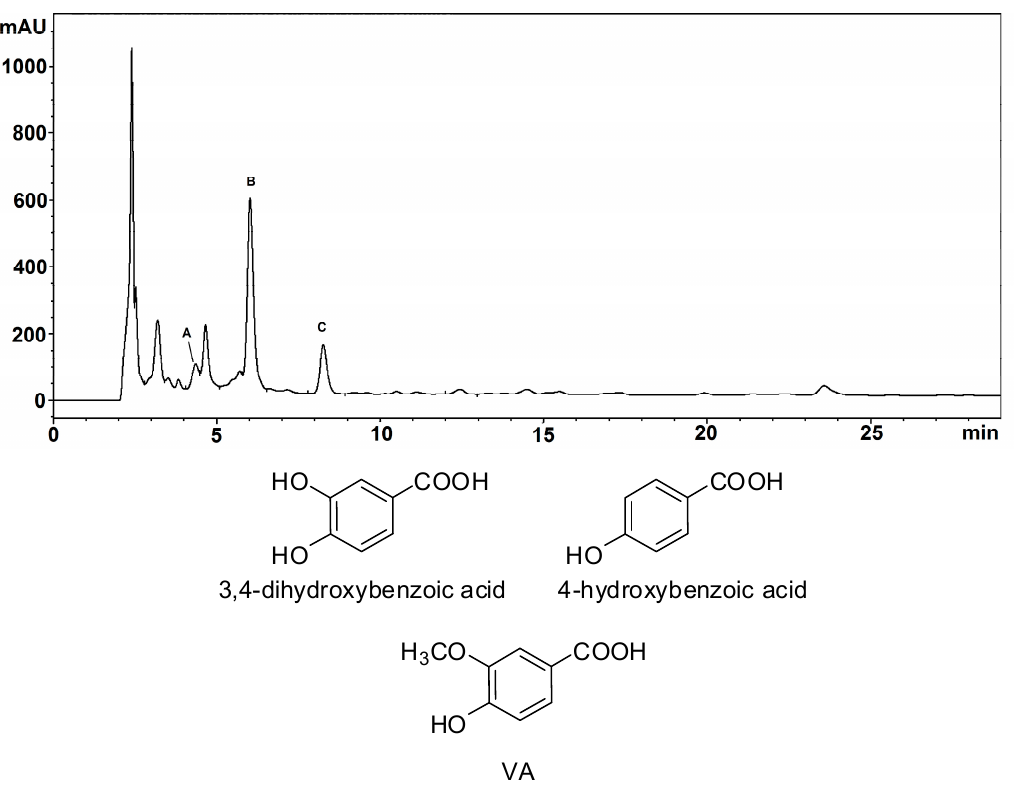
Figure 1. HPLC trace (detection at 254 nm) of the ethyl acetate extractable fraction of the alkali fusion mixture of BSP. Peak A: 3,4-dihydroxybenzoic acid; peak B: 4-hydroxybenzoic acid; peak C: VA. The chromatographic separation was performed on an octadecylsilane (ODS) column (325 × 4.60 mm, 5 µm), at a flow rate of 0.9 mL/min. The mobile phase was a 0.02 M ammonium acetate buffer, pH = 3.5 (solvent A)/methanol (solvent B) gradient as follows: from 5% to 25% B, 0–20 min. Chemical structures of the identified compounds are also shown.